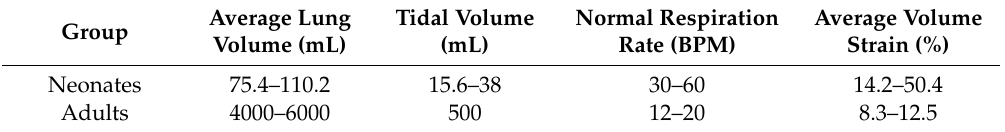
Table 1. Average lung volumes as well as the average respiration rate for adults and infants [48–52].